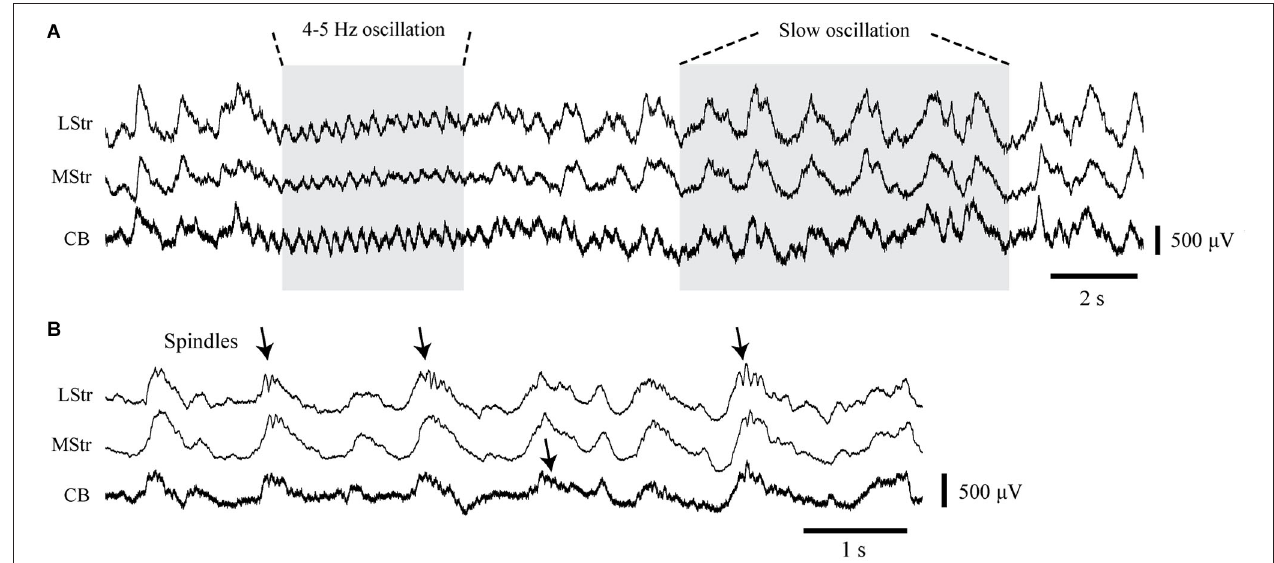
concurrent periods of 4–5 Hz oscillations and slow 1 Hz oscillations. (B) Recordings at an expanded time scale obtained from another recording period show spindle-like activity in association with slow waves